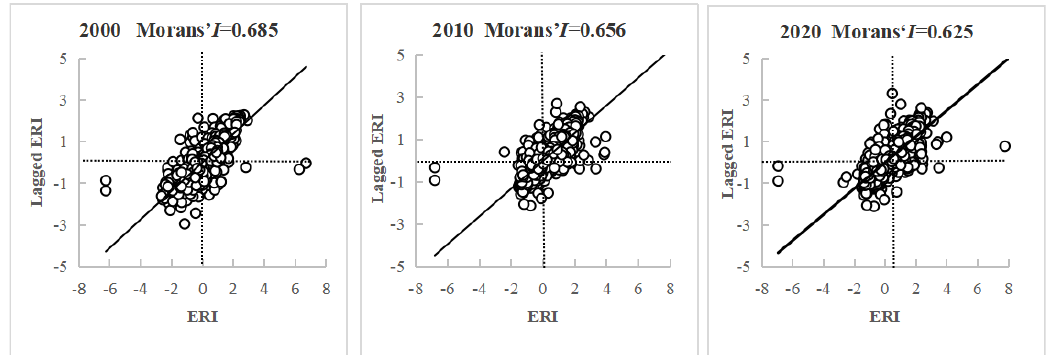
Figure 4. Spatial distribution ( a ) and proportion ( b ) of ecological risk under three different scenarios in 2030.